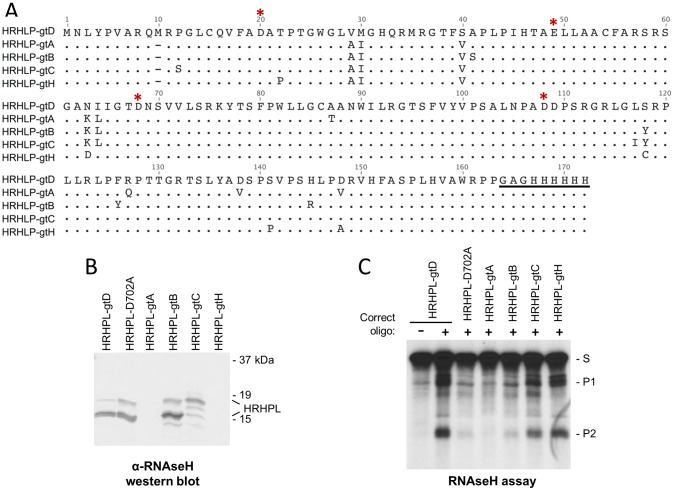
Recombinant RNAseHs from HBV genotypes A, B, C, D, and H.
A. Sequence alignment for genotype A, B, C, D, and H versions of the HBV RNAseH expression construct HRHPL. The additional methionine at residue 10 of the genotype D sequence is a product of the cloning strategy; this insertion has no impact on the RNAseH activity because the first 9 amino acids of HRHPL can be deleted without altering the biochemical profile of the enzyme. * indicates the DEDD active site residues, and the hexahistidine tag at the C-terminus is underlined. Residue 1 for the HBV RNAseH domain is amino acid 684 in the full-length polymerase protein (strain adw2). B. Western analysis of RNAseH proteins in the enriched lysates probed with the anti-HBV RNAseH monoclonal antibody 9F9. C. RNAseH activity of RNAseH from HBV genotypes A, B, C, D, and H detected by the oligonucleotide-directed RNA cleavage assay. HRHPL-D702A (genotype D) is a negative control. gt, genotype.